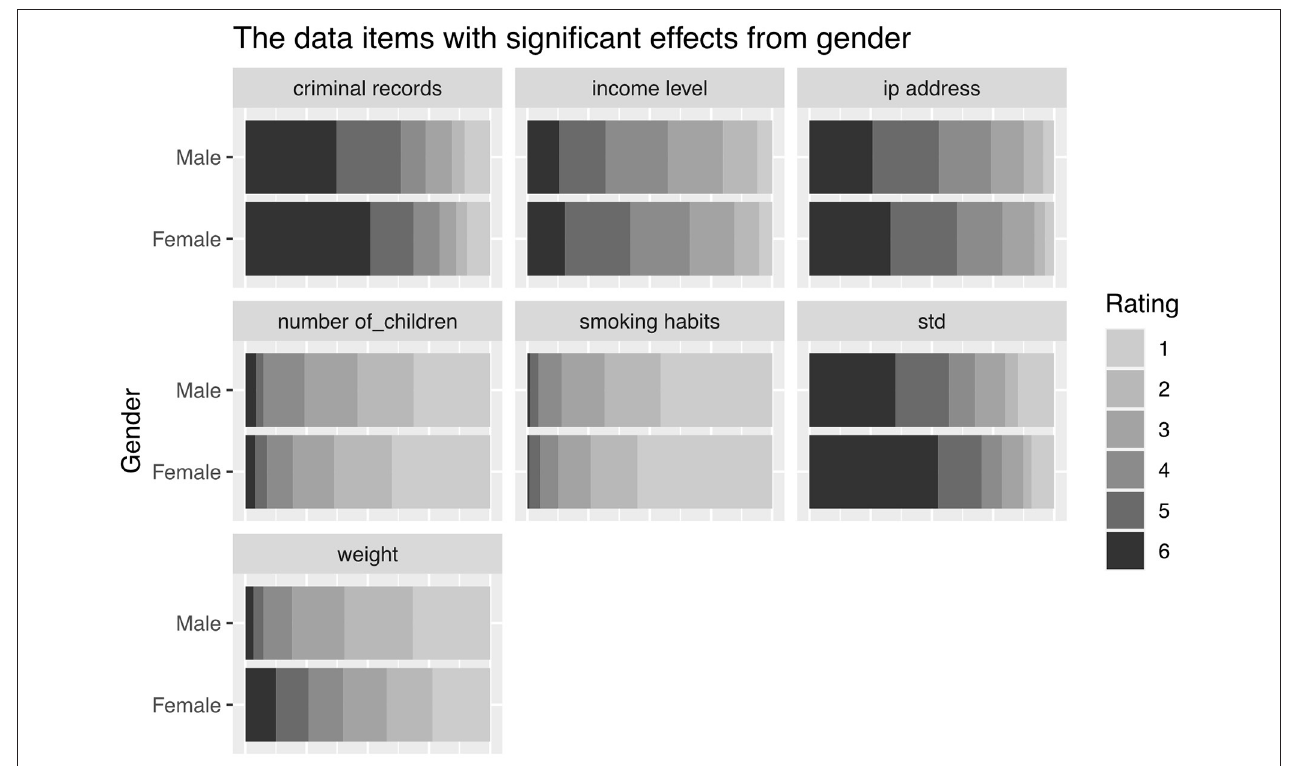
FIGURE 3 | The data items with significant effects from